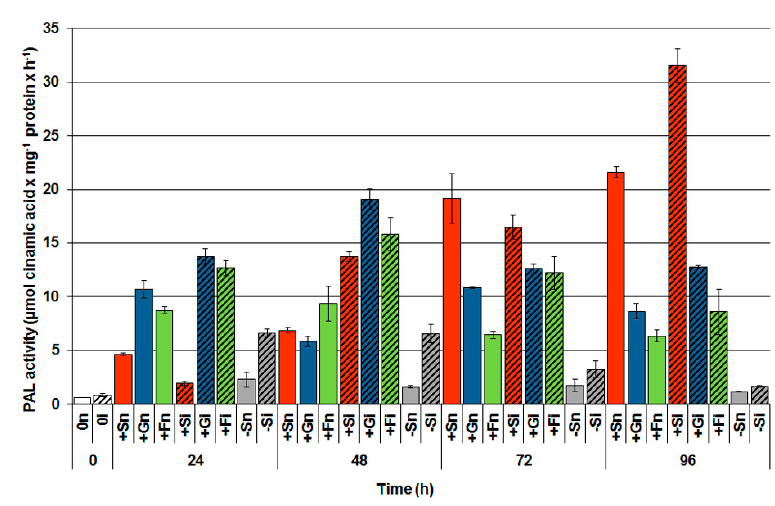
Figure 5. Effect of sucrose, glucose and fructose on the activity of phenylalanine ammonia-lyase (PAL) in in vitro cultured embryo axes of Lupinus luteus infected with Fusarium oxysporum f. sp. lupini . A summary of the statistical significance of differences between the average values of each pair at p < 0.05 can be found in the Supplementary Files (Table S7).